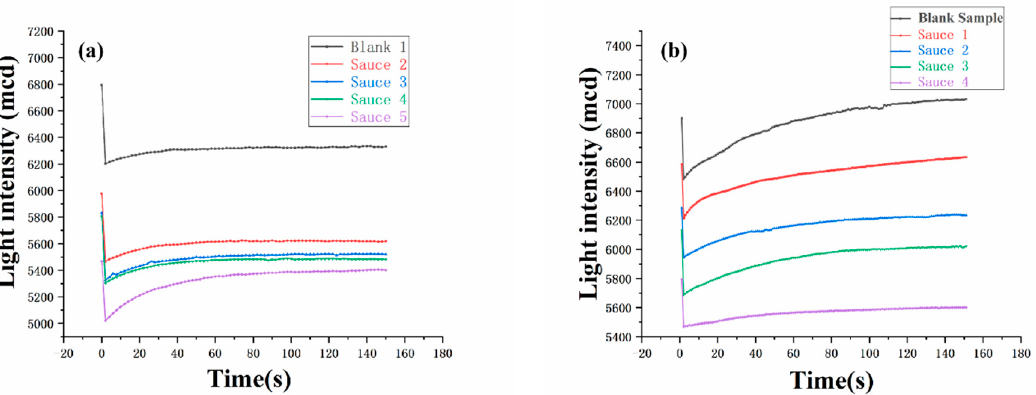
Figure 5. Time variation of the light intensity of ( a ) 365 nm and ( b ) 395 nm lamp beads after passing through different liquor